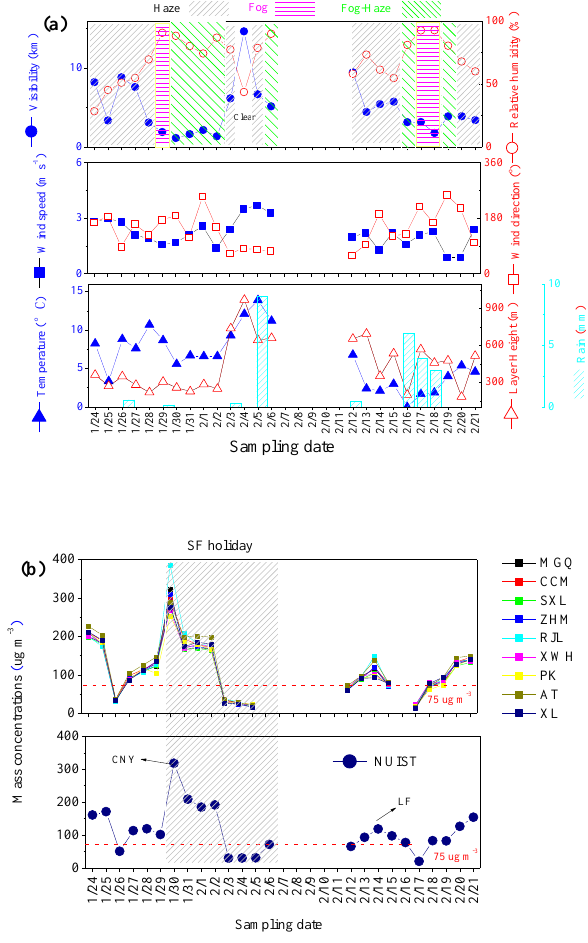
Figure 2. Daily variation of meteorological factors (a) and mass concentrations of PM 2 . 5 (b) during sampling periods. MGQ, CCM, SXL, ZHM, RJL, XWH, PK, AT and XL indicate the nine urban air quality monitoring sites set by Jiangsu Environmental Monitor- ing Center as Supplement Fig. S4 shown. NUIST indicates the sam- pling site of this study at Nanjing University of Information Science and Technology. SF means Spring Festival (between 30 January– 7 February); CNY means Chinese New Year day (30 January); LF means Lantern Festival day (14 February). 75µgm − 3 is the 24h av- eraged secondary standard value for PM 2 . 5 of China National Am- bient Air Quality